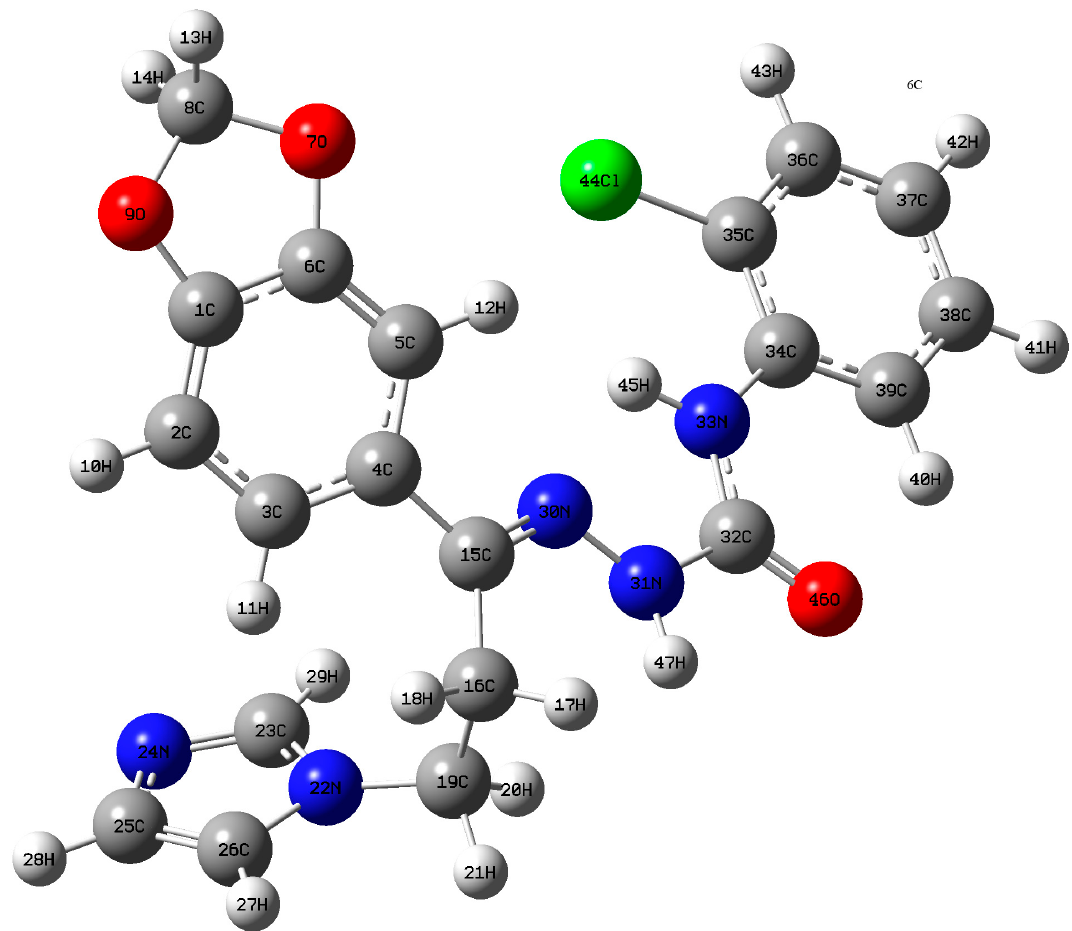
Figure 3. Atom numbering scheme of optimized semicarbazone 4 structure. 171